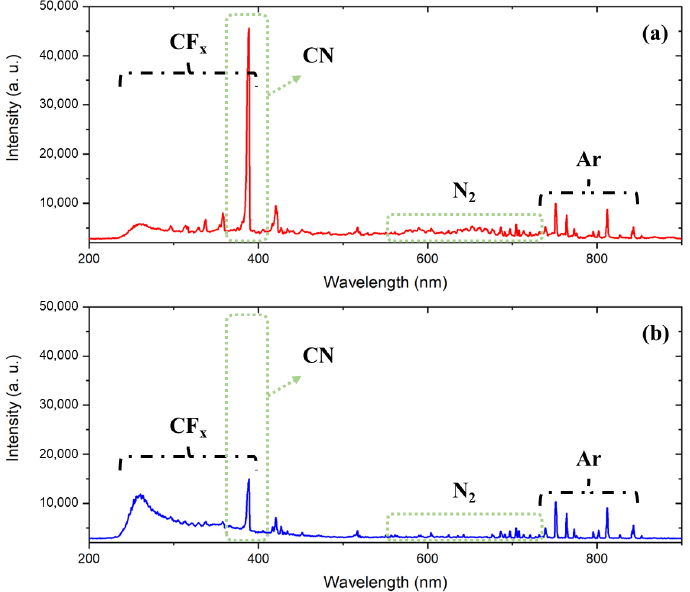
Figure 3. Leakage reduction verification using CF 4 plasma. ( a ) before and ( b ) after O-ring replacements. After replacement, the intensity of CN and N 2 drastically reduced. However, the remaining CN and N 2 peaks were observed, suggesting that the leakage was not completely controlled. Coatings 2022 , 12 , 1064